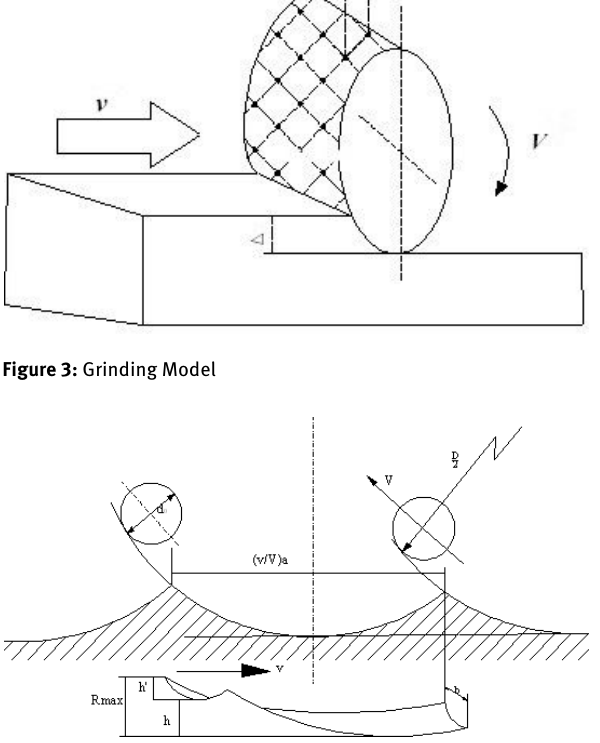
Figure 4: The cutting streak model of the grinding wheel cutting